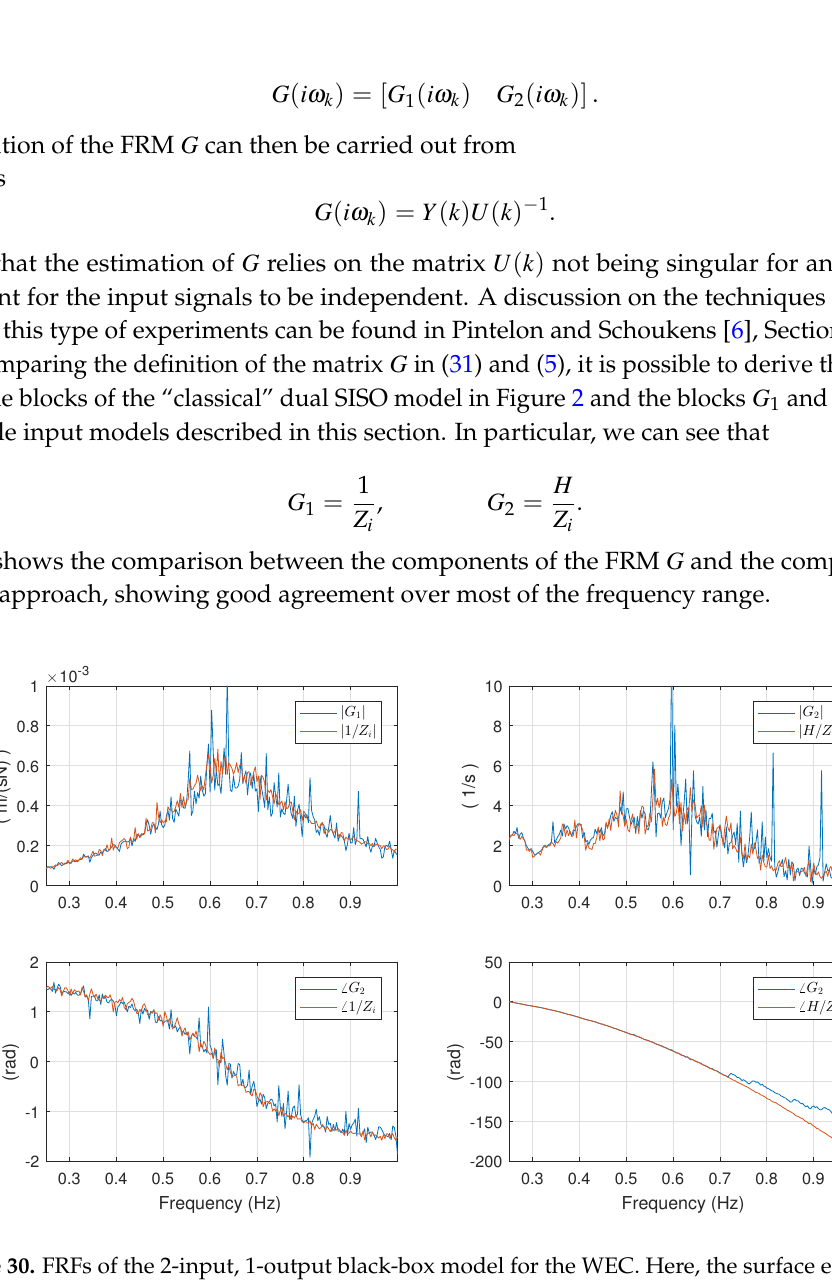
Figure 30. FRFs of the 2-input, 1-output black-box model for the WEC. Here, the surface elevation is measured in inches and the force in